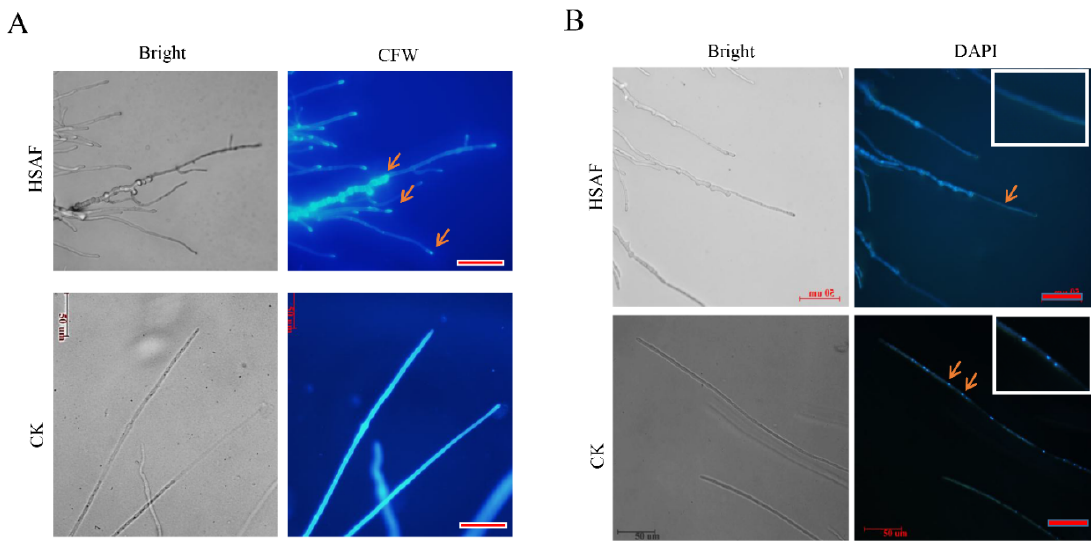
Figure 2. HSAF induced cell wall thickened and caused cell apoptosis in A. alternata. ( A ) Mycelial microscopic morphological characteristics and cell wall staining by CFW (Calcofluor white). The strains were cultured on coverslips with a layer PDA medium amended with HSAF or methanol (CK) at 25 ◦ C for 24 h, then staining by CFW. The pictures were taken by fluorescent inverted/phase contrast microscope (ZEISS). The arrows indicate the well-staining areas that were similar to the control. Bar = 50 µ m. ( B ) Hyphal apoptosis was induced by HSAF. The strains were cultured on the conditions same to the ways above. The mycelia were staining by DAPI. The pictures were also taken by fluorescent inverted/phase contrast microscope (ZEISS). The small panels were enlarged area from these arrows indicated sites. Bar = 50 µ m.